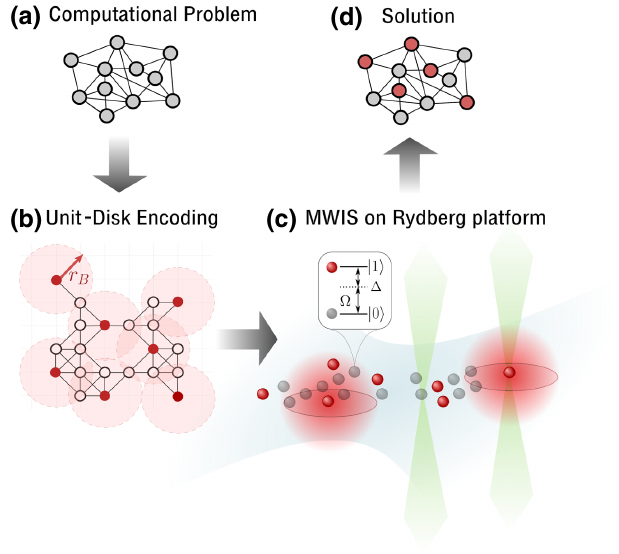
FIG. 1. Procedure to solve a variety of optimization problems using programmable Rydberg atom arrays. The original compu- tational problem (a) can be mapped onto a MWIS problem on a UDG in (b). (c) Physical platform, where each vertex in (b) represents an atom trapped by optical tweezers. Each two-level atom can be coherently driven with Rabi frequency (cid:2) and detun- ing (cid:3) , and the Rydberg-blockade mechanism prevents two atoms from being simultaneously excited to state | 1 (cid:2) if they are within a unit distance r B . (d) The solution to the UDG-MWIS problem encodes the solution to the original